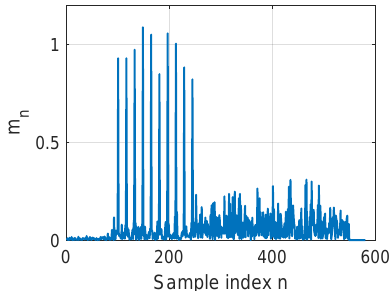
Figure 12. The response of cross-correlation